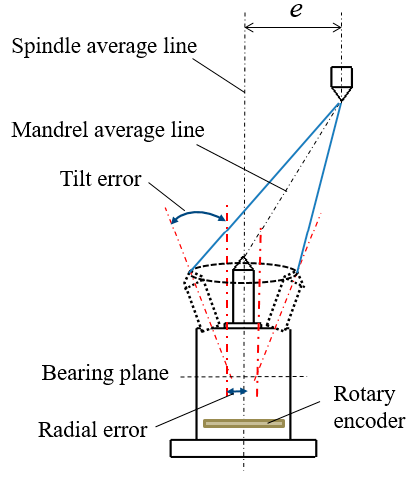
Figure 2. Actual spindle and coaxiality errors existed in the gear measuring machine (GMM).